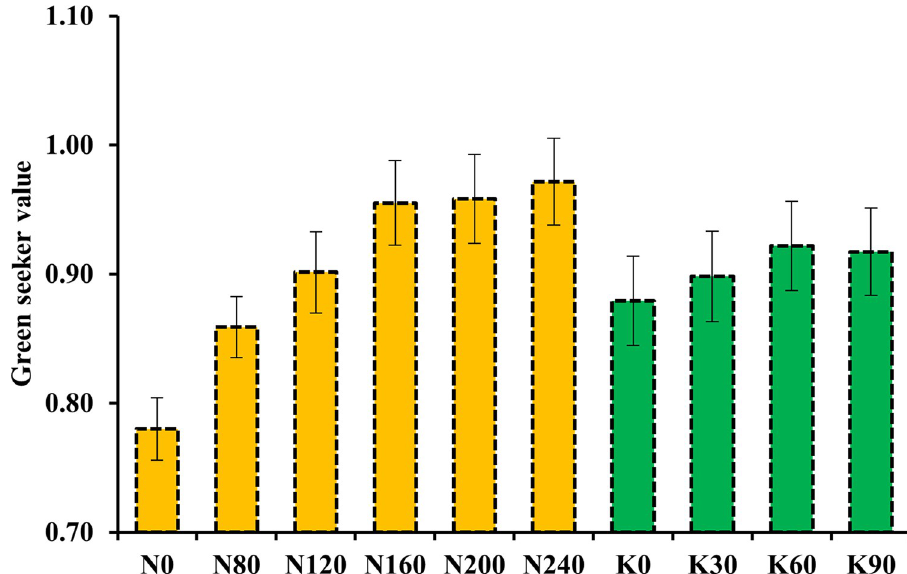
Fig 5. Effect of nitrogen (N) and potassium (K) application on green seeker value for wheat ( Triticum aestivum L.) in a sandy loam soil in sub-tropical India. Bars indicate the standard error from mean (S . E .